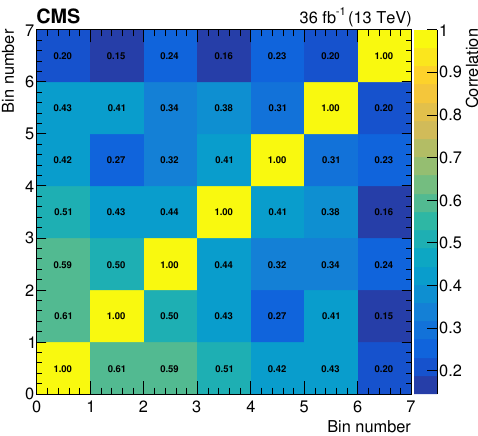
Figure 19 . Correlations between background predictions in each of the bins of the tight signal region, after performing the (cid:12)t in only the control regions.